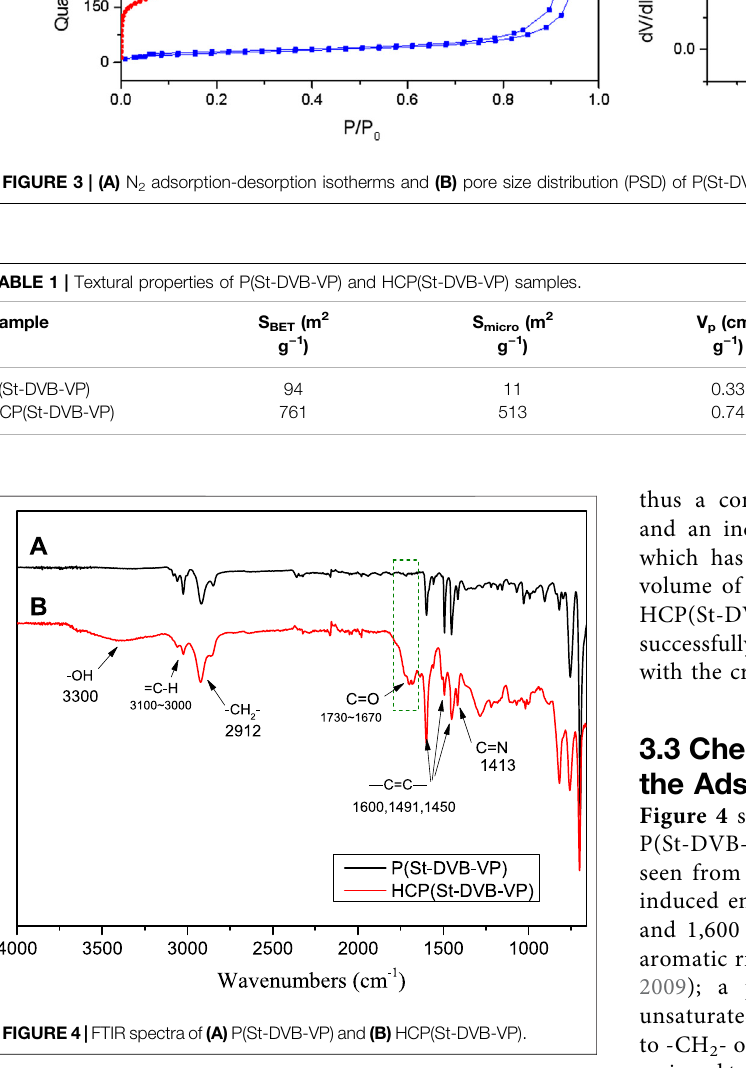
Frontiers in Chemistry |